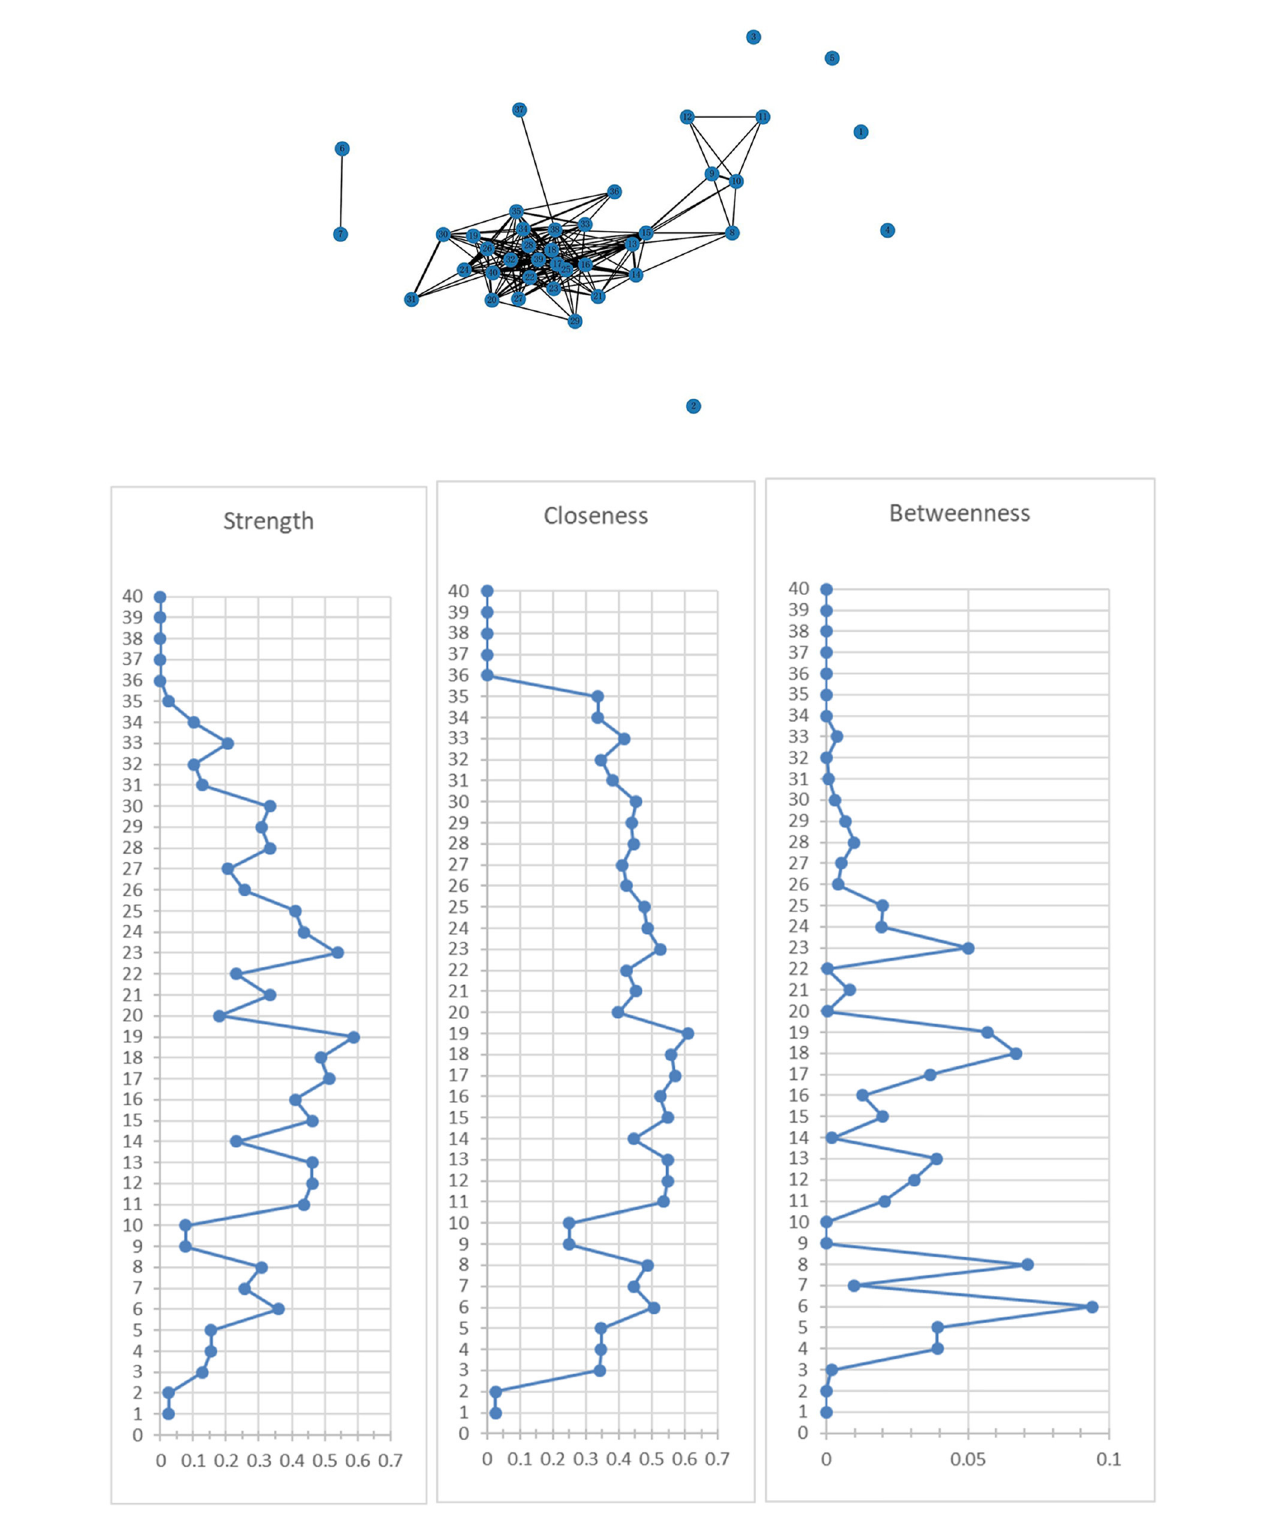
FIGURE1 Network of mental health symptoms and centrality indices. 1. Feeling weak in parts of your body; 2. Faintness or dizziness; 3. Hot or cold spells; 4. Numbness or tingling in parts of your body; 5. Nausea or upset stomach; 6. Pain in the heart or chest; 7. Trouble catching your breath; 8. Difficulty concentrating; 9. Having slow reactions; 10. Forgetting things that occurred recently; 11. Difficulty reasoning; 12. Becoming confused; 13. Jittery; 14. Nervous; 15. Afraid; 16. Upset; 17. Distressed; 18. Guilty; 19. Hostile; 20. Ashamed; 21. Irritable; 22. Scared; 23. Your feelings are easily hurt; 24. Feeling that people are unfriendly or dislike you; 25. Feeling inferior to others; 26. Feeling very self-conscious around others; 27. Uncertainty about the future; 28. Feeling discouraged about the future; 29. The belief that I should be punished for my sins; 30. Lack of confidence around others; 31. Feeling that I am being watched or talked about by others; 32. Feelings of worthlessness; 33. Suicidal ideas; 34. Escaping from reality; 35. Unable to integrate into society; 36. Unable to handle daily work and study; 37. Sleep disturbance; 38. Loneliness; 39. Sadness; 40.